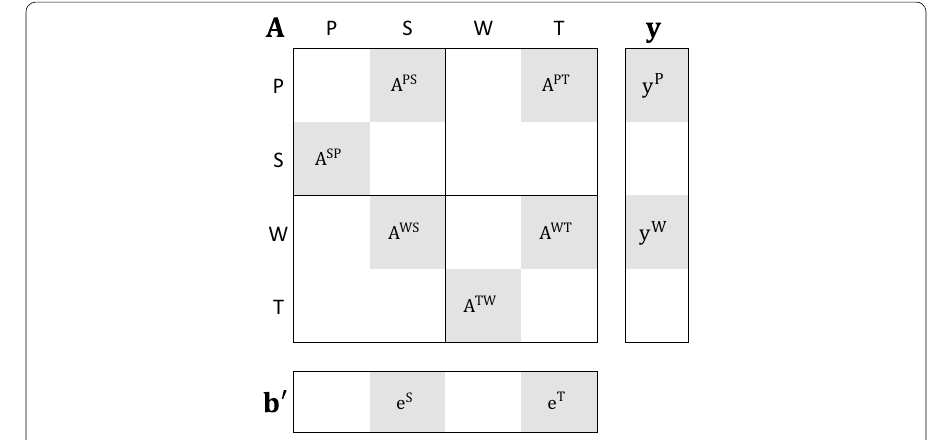
Fig. 3 Simplified waste supply‑use table. y final demand vector; A technology matrix; b ′ intensity = = = vector. P product or service, S sector or industry, W waste, T waste treatment or recycling activity. = = = = y P elements are monetary values (M.EURO). y W elements are physical units (tonnes). A PS and A SP elements are coefficients from monetary units (M.EUR/M.EUR). A WS elements are coefficients from physical and monetary units (tonnes/M.EUR). A TW and A WT elements are coefficients from physical units (tonnes/tonnes). A PT elements are coefficients from monetary and physical units (M.EUR/tonnes). e S elements represent coefficients from physical values, depending on the environmental pressure, and monetary units (e.g. CO 2 tonnes/M.EUR). e T elements represent coefficients from physical values, depending on the environmental pressure, and physical units (e.g. CO 2 tonnes/tonnes). Empty cells contain